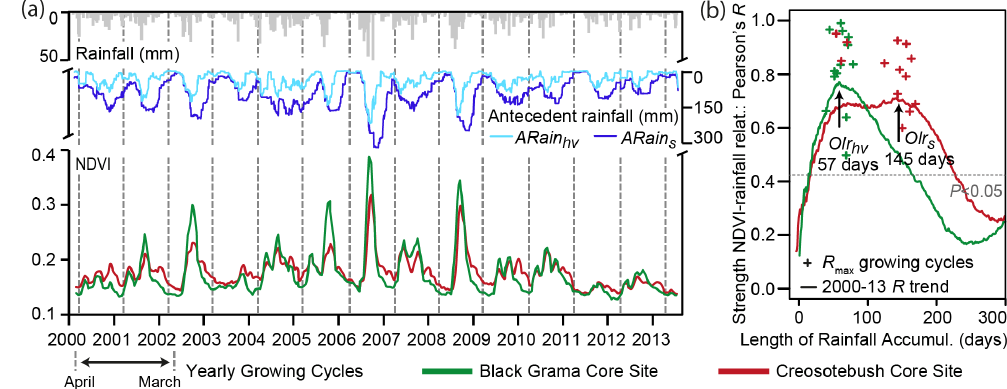
Figure 3. Reference NDVI–rainfall relationships at the SEV LTER Black Grama and Creosotebush core sites: (a) 2000–2013 MODIS NDVI time series for the core sites and (b) strength of the NDVI–rainfall relationship (Pearson’s R correlation) for the core sites using different lengths of rainfall accumulation (maximum correlations, R max , for the annual cycles of vegetation growth are shown together with the 2000– 2013 mean trend; detailed correlograms for each growing cycle can be found in Supplement Fig. S1). R values above the dotted grey line are significant at P < 0 . 05. ARain hv and ARain s lines in panel (a) represent the antecedent rainfall series that best correlate with the NDVI series for the Black Grama and Creosotebush Core sites (i.e. time series of precedent rainfall with rainfall accumulation lengths Olr hv and Olr s , respectively). Reference Olr hv and Olr s values in panel (b) represent the optimal rainfall accumulation lengths for herbaceous vegetation (57 days) and shrubs (145 days),